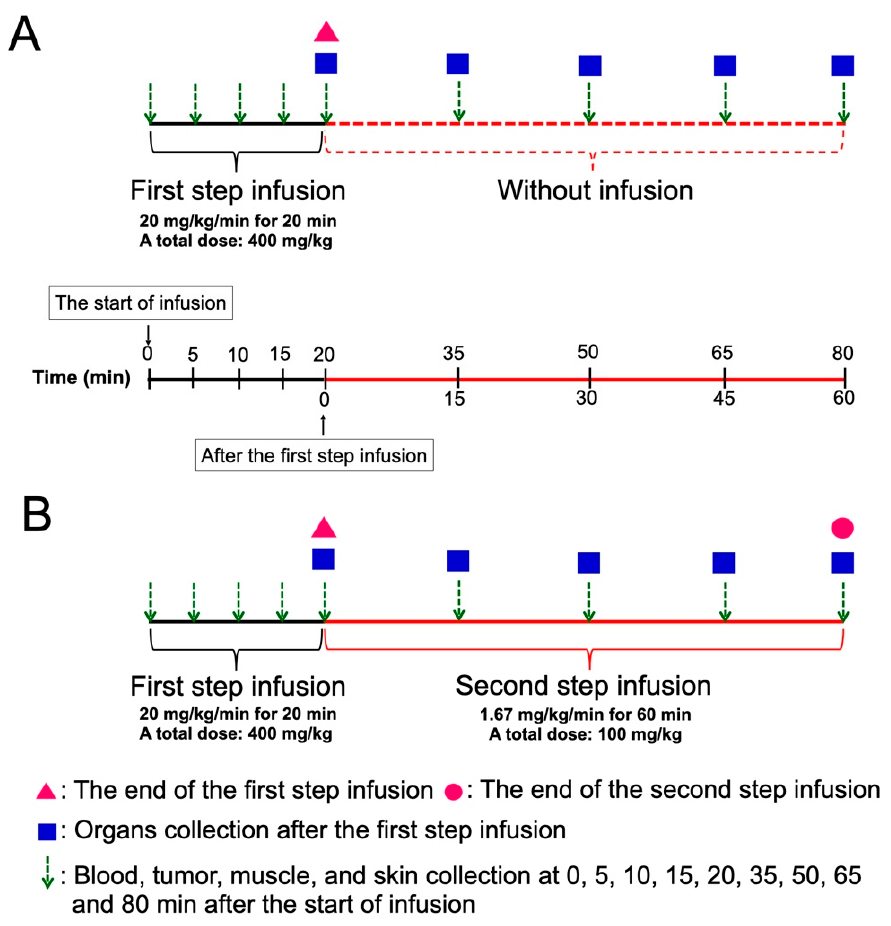
Figure 1. A scheme of the experimental design in ( A ) one-step infusion (OSI) and ( B ) two-step infusion (TSI) groups is shown. Total doses of the second step infusion at 15, 30, 45, and 60 min were 25, 50, 75, and 100 mg/kg, respectively.